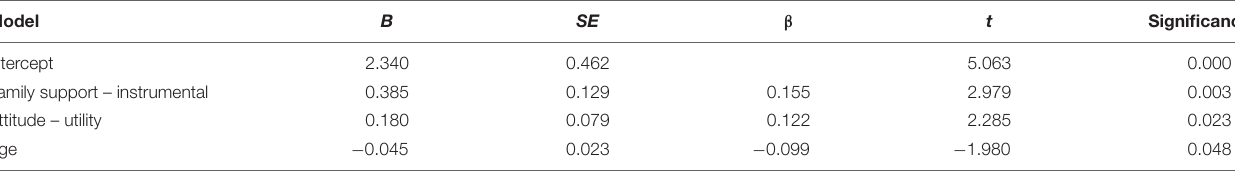
TABLE 4 | Summary of stepwise multiple regression analysis predicting boys’ PLC classifications. Model